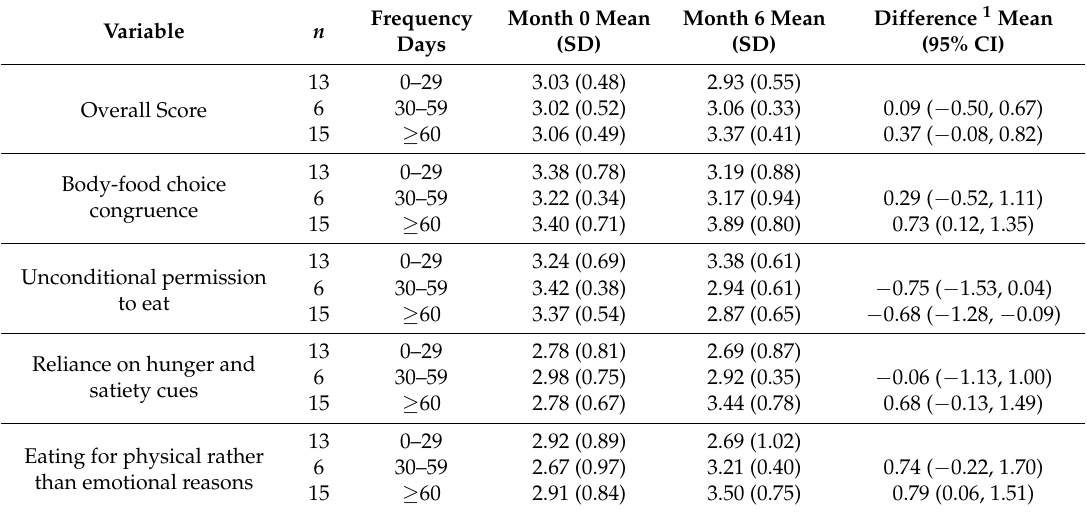
Table 5. Effect of frequency of hunger training on intuitive eating using the IES-2